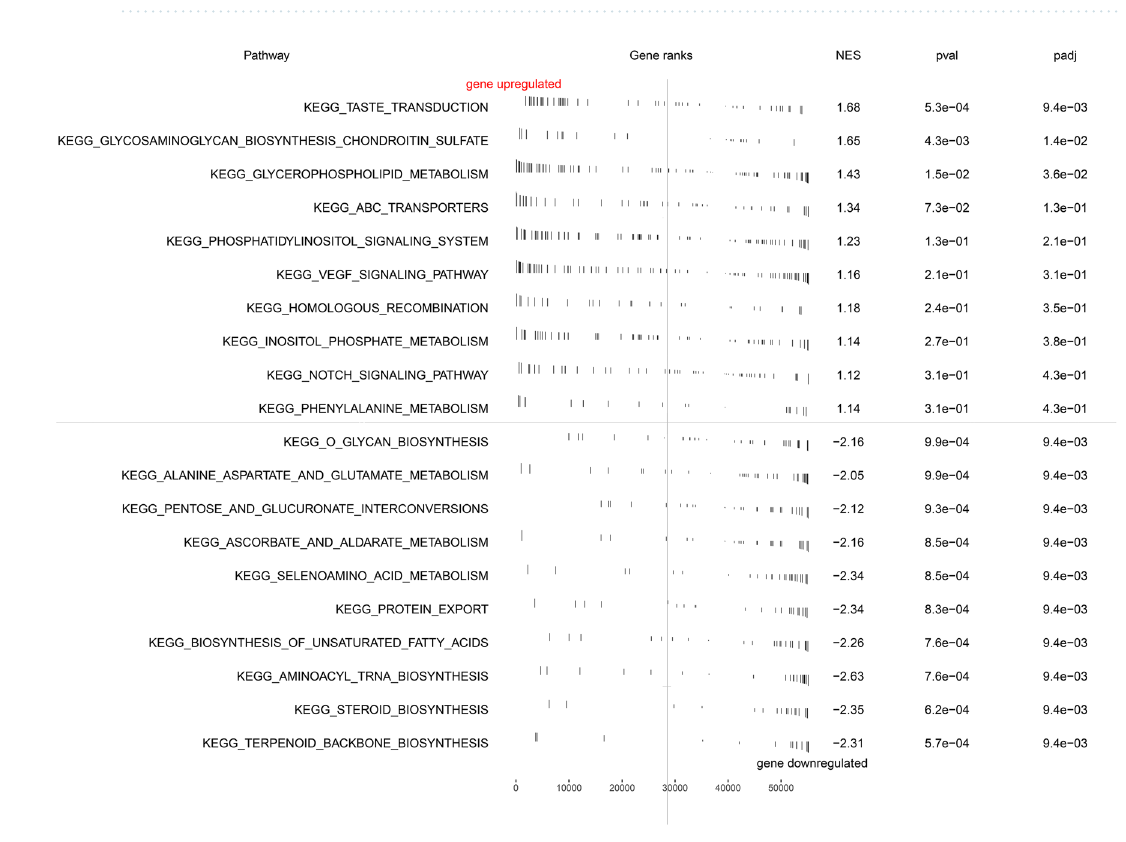
Figure 5. Construction of a nomogram based on risk score and clinical information. ( A ) The nomogram plot; ( B ) The calibrations of 1, 3, 5 years.